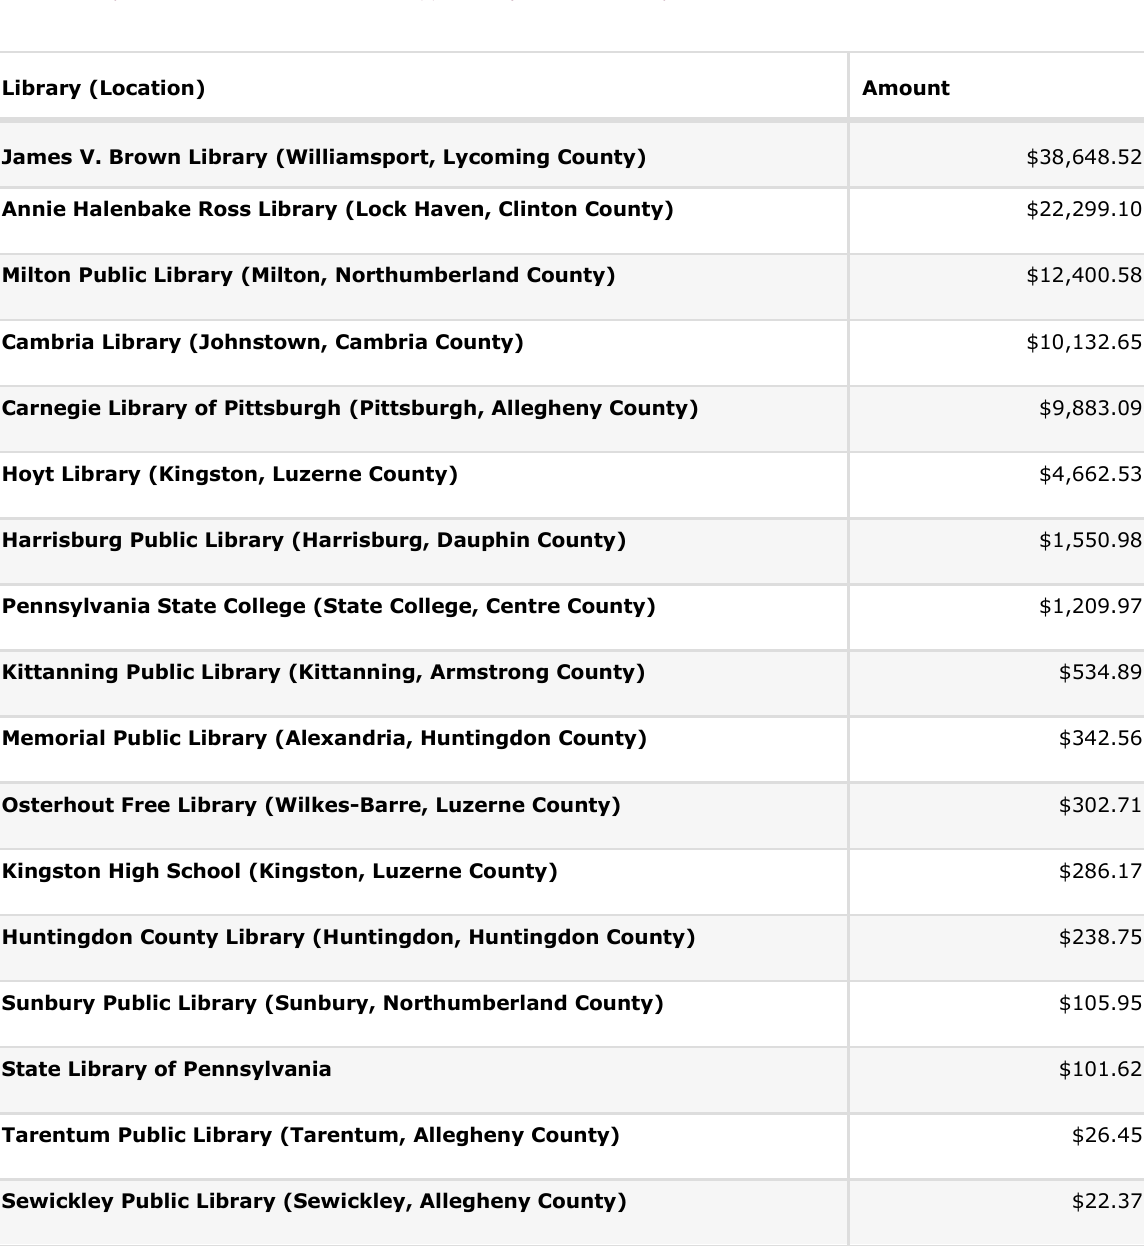
Distribution of State Aid to Flooded Libraries Approved by State Council of Education